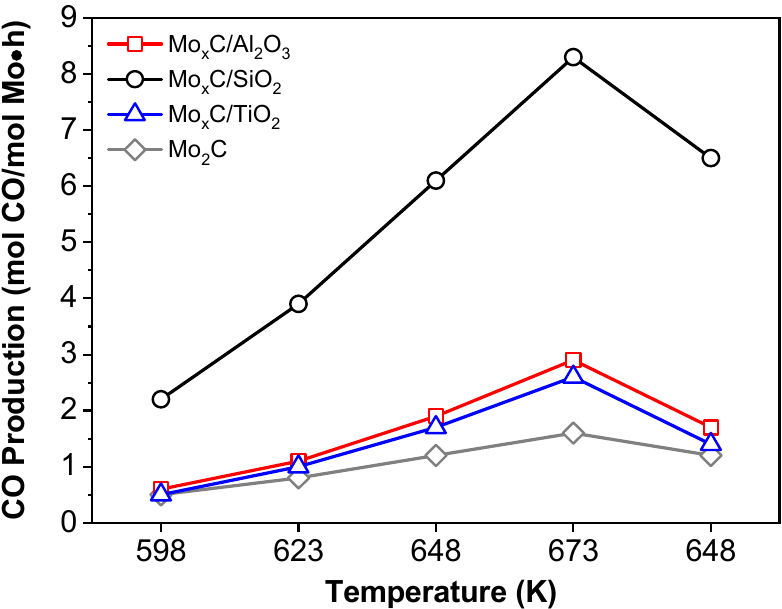
Figure 11. CO production per mol Mo as a function of reaction temperature in RWGS over Mo x C/support and unsupported reference Mo 2 C catalysts. Reaction conditions: m cat = 150 mg, CO 2 /H 2 /N 2 = 1/1/3, GHSV = 3000 h − 1 , P = 0.1